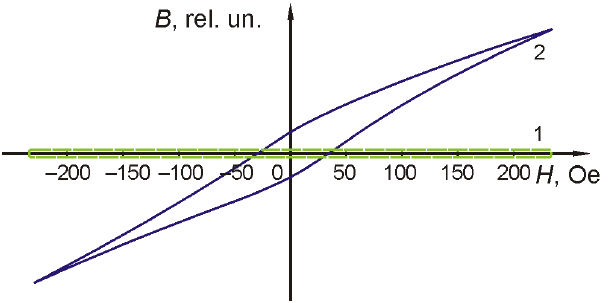
Figure 5. Hysteresis loops of Ni 51 Ti 49 alloy before (1) and after (2) plastic deformation.